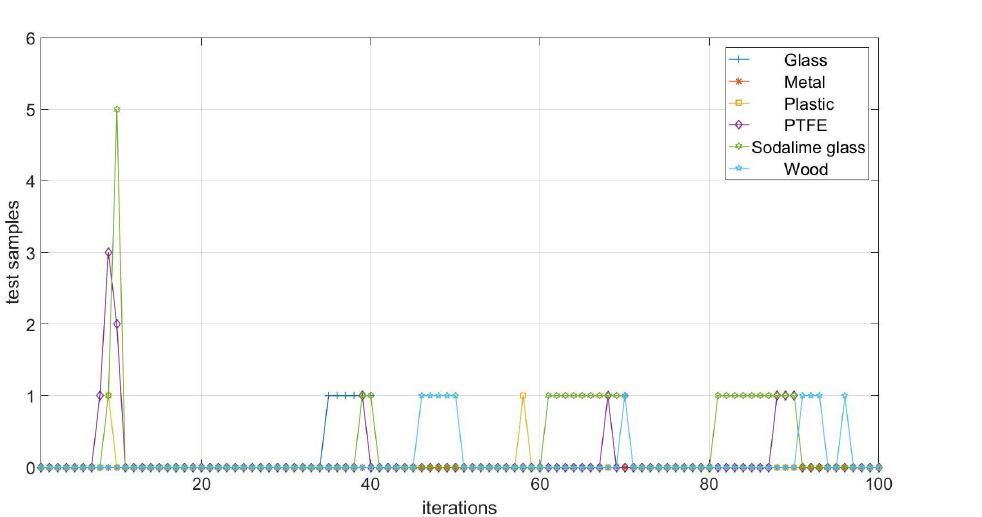
Figure 12. The plot of the misclassified terms FP and FN of the confusion matrices for each contam- inated class alone. The results obtained by the non-linear SVM algorithm trained on the Complex nature